Question: Provide a one-line summary of what is displayed.
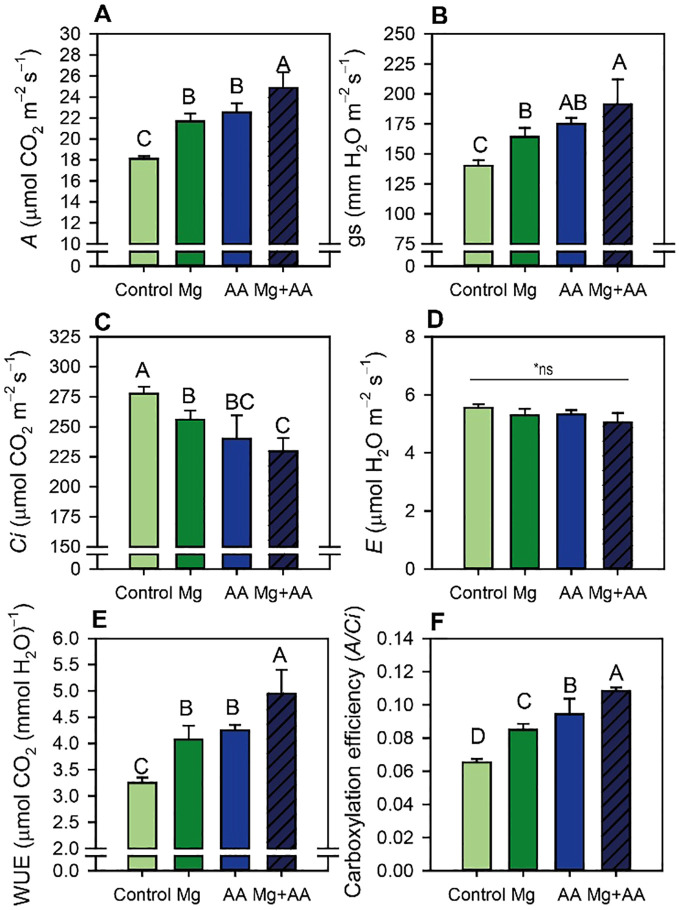
Answer: Photosynthetic parameters in maize leaves as affected by the foliar application of magnesium (Mg) and/or amino acids (AA): (A) net photosynthesis (A), (B) stomatal conductance (gs), (C) CO 2 concentration in the stomatal chamber (Ci), (D) leaf transpiration (E), (E) water use efficiency (WUE), and (F) carboxylation efficiency ( A/Ci ). Bars represent means across the 2021 and 2022 off-season growing periods. Different letters indicate significant differences among treatments (LSD, p ≤ 0.05). ns, not significant. Error bars represent standard deviation (n = 8). *ns, not significant.